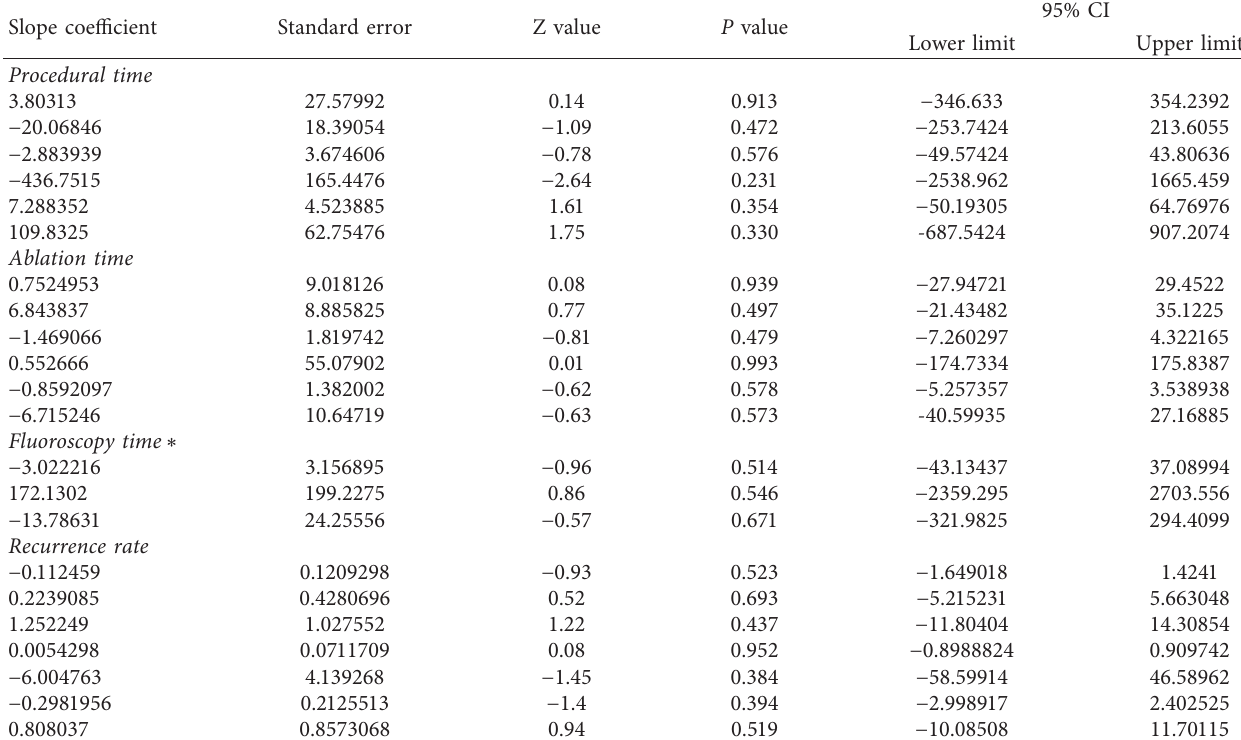
Table 3: Results of the meta-regression analysis for procedural